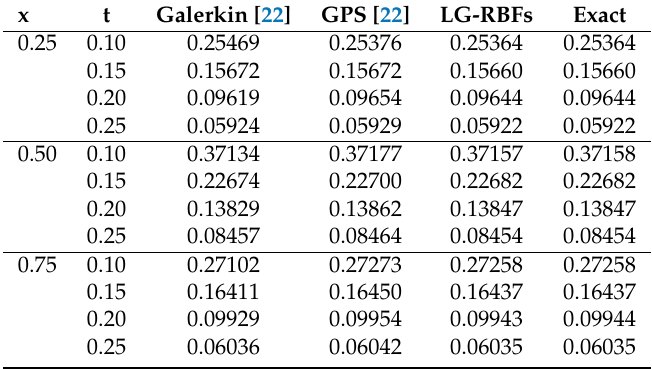
Table 1. Comparison of the approximate solution at different final times with v = 1, M = 40 and ∆ t = 0.0001.